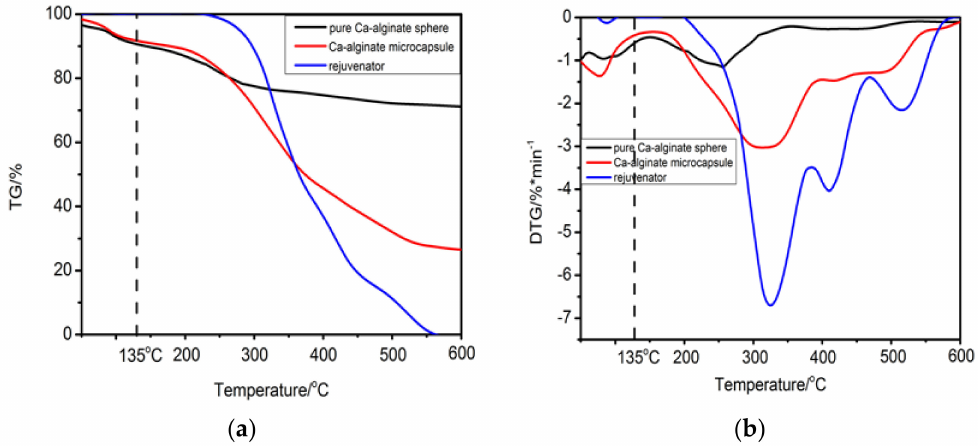
Figure 8. Thermal analysis of alginate, Ca-alginate microcapsules and rejuvenator: ( a ): TG vs. temperature, ( b ): DTG vs.